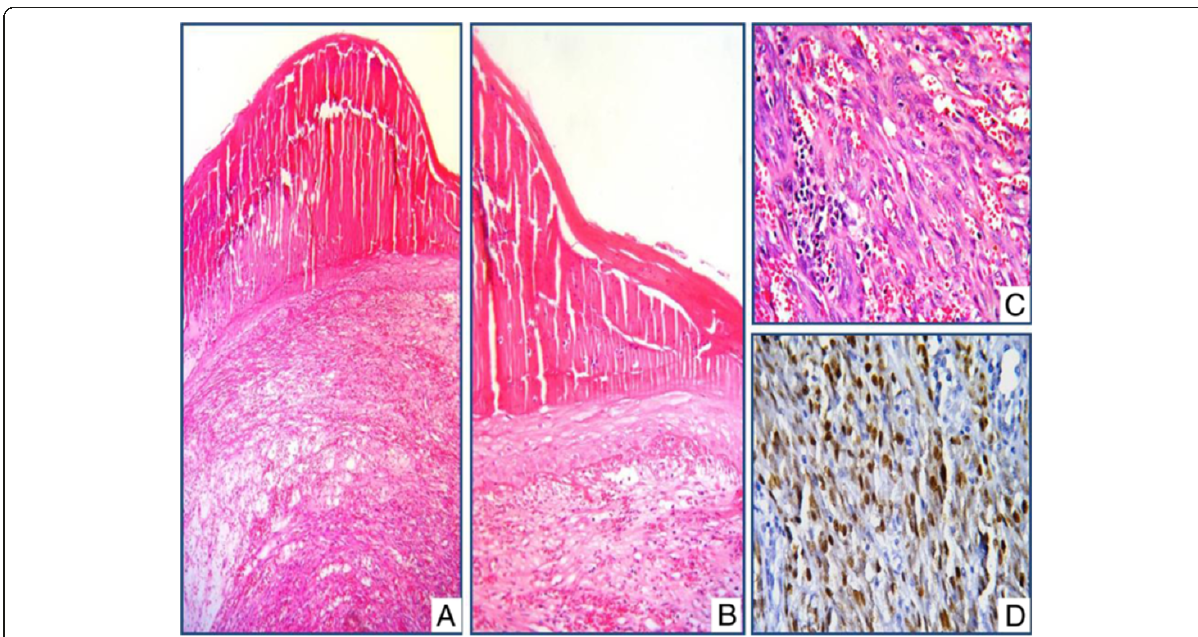
Figure 2 Hyperkeratosis (A) and serum exudation within keratin layer in epidermis and enlarged lymphatic vessels (B) in superficial dermis are observed in bullous KS (A-B; H&E, X400).